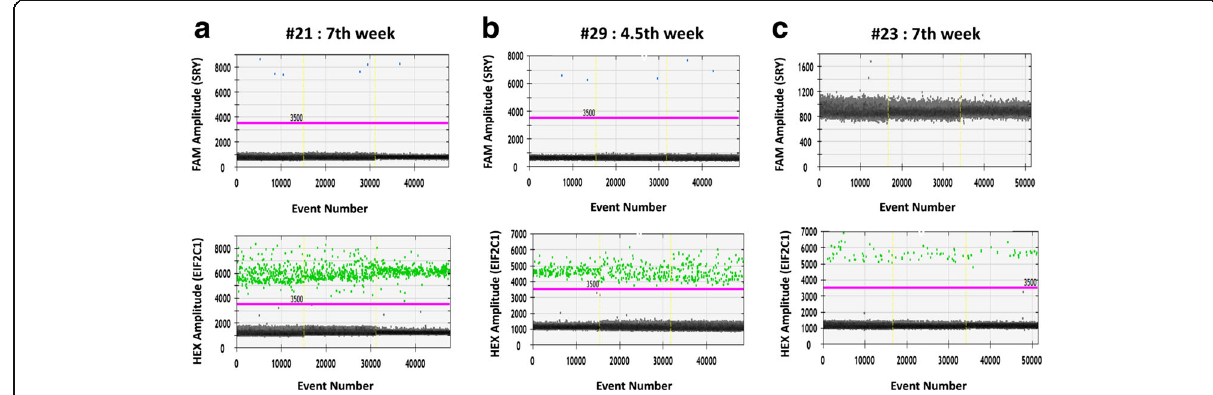
Fig. 3 Representative graphs for circulating DNA samples at different gestational ages analyzed by ddPCR. Three circulating DNA samples, extracted from maternal plasma at different gestational weeks and carrying male ( a , #21: 7th week; #29: b , 4,5th week) or female fetus ( c , #23:7th week), were analyzed in ddPCR for SRY (FAM) and EIF2C1 (HEX) gene targets. For all three samples, the upper graphs correlate the FAM fluorescence intensity, corresponding to the SRY gene (blue dots), to the number of positive events; the lower graphs report the HEX fluorescence intensity, relative to the EIF2C1 reference gene (green dots), to the number of positive events. Black dots indicate negative events (no amplification events). The threshold lines are coloured in